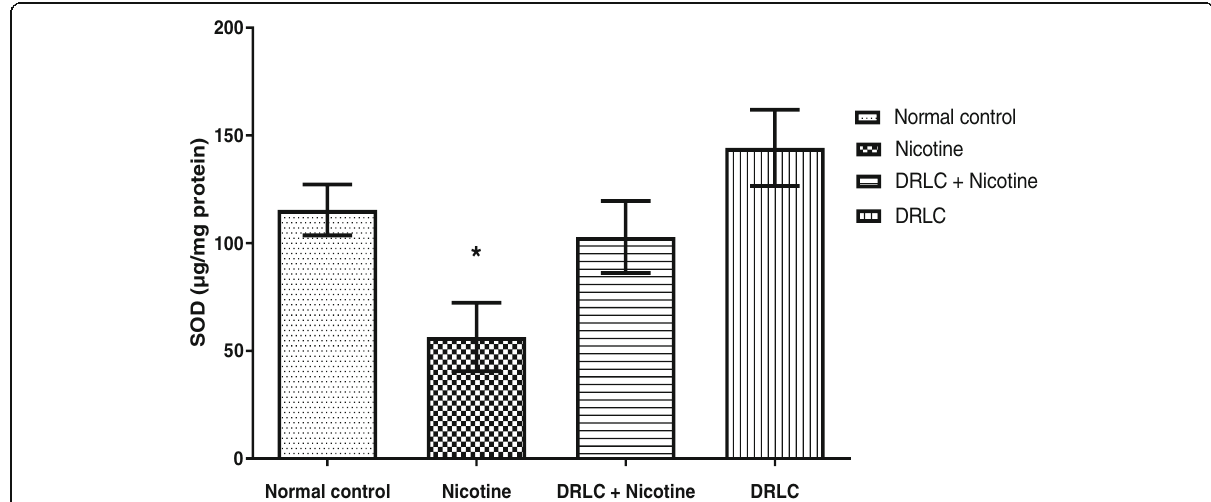
Fig. 3 Charts showing SOD levels in the testes of experimental animals. Values are mean ± SEM; N = 5. *Statistically different from normal control, DRLC + nicotine, and DRLC groups (p <